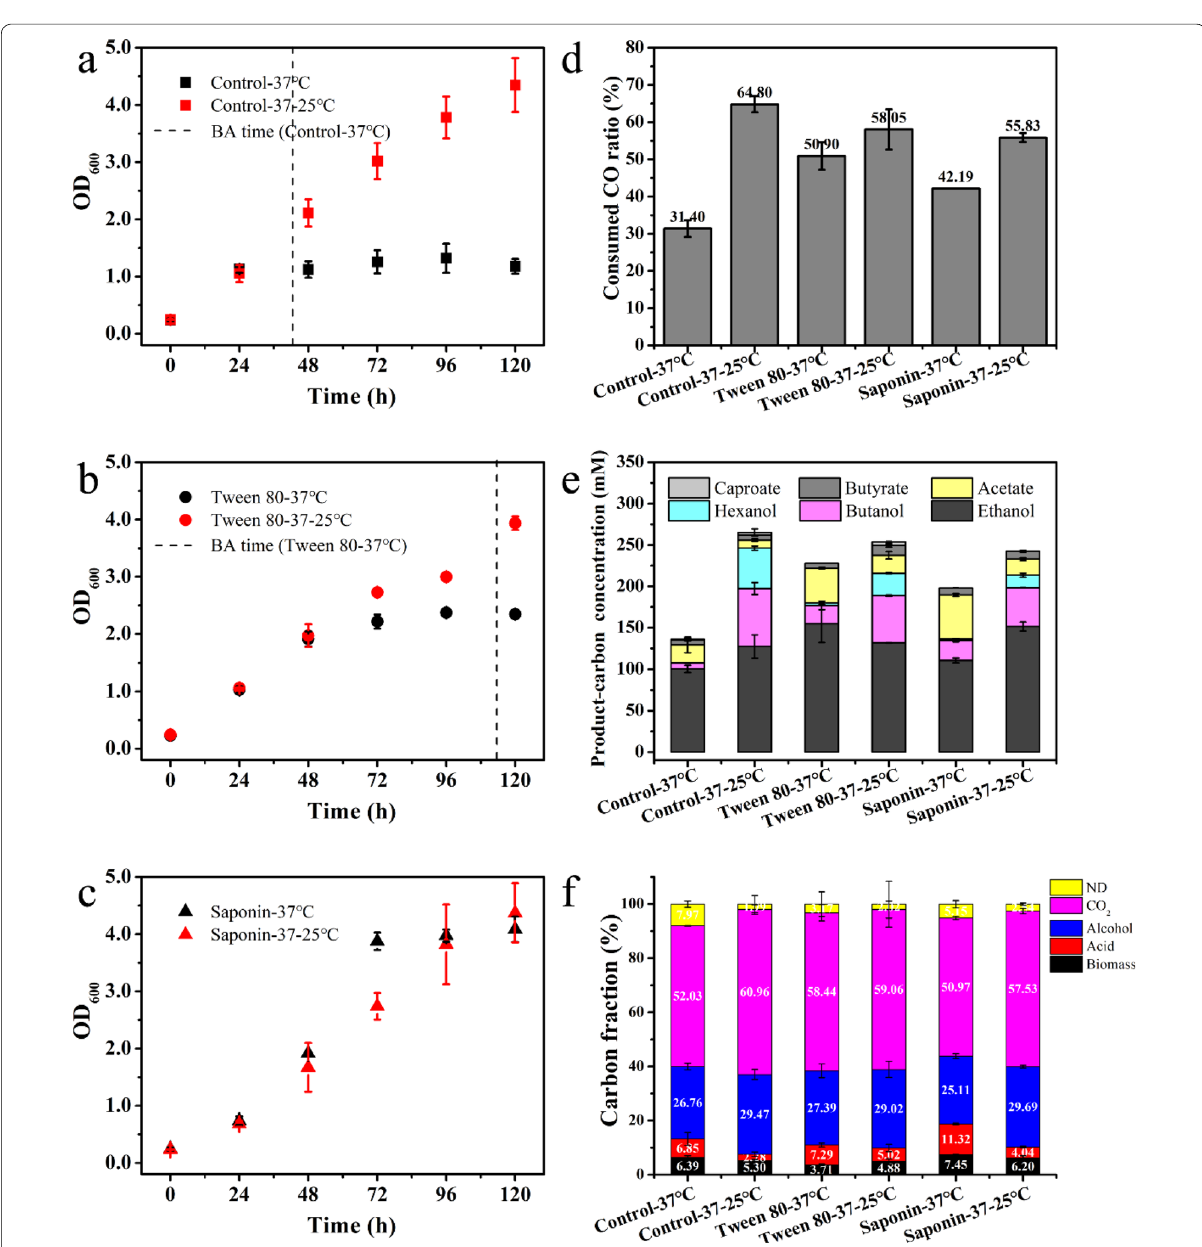
Fig. 3 Growth, production, carbon monoxide consumption and carbon fraction by C. carboxidivorans P7 using different culture strategies. Mean values and standard errors of three replicates are shown in all graphs. Optical densities at 600 nm (OD 600 s) in the culture of 37 °C and 37–25 °C, a without any surfactant, b with Tween 80 and c with saponin; and a , b the approximate time when bacterial agglomerates appeared (the BA time) in the culture of 37 °C. d Consumed carbon monoxide ratios during 0–120 h. e Product-carbon concentrations (mmol/l) from ethanol, butanol, hexanol, acetate, butyrate and caproate at 120 h. f Carbon fraction at 120 h, mainly consisting of biomass, alcohol, acid, carbon dioxide and not detected